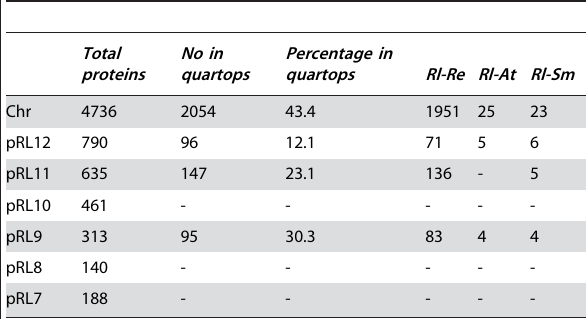
Table 1. Quartops analysis with R. leguminosarum , R. etli , A. tumefaciens and S. meliloti .